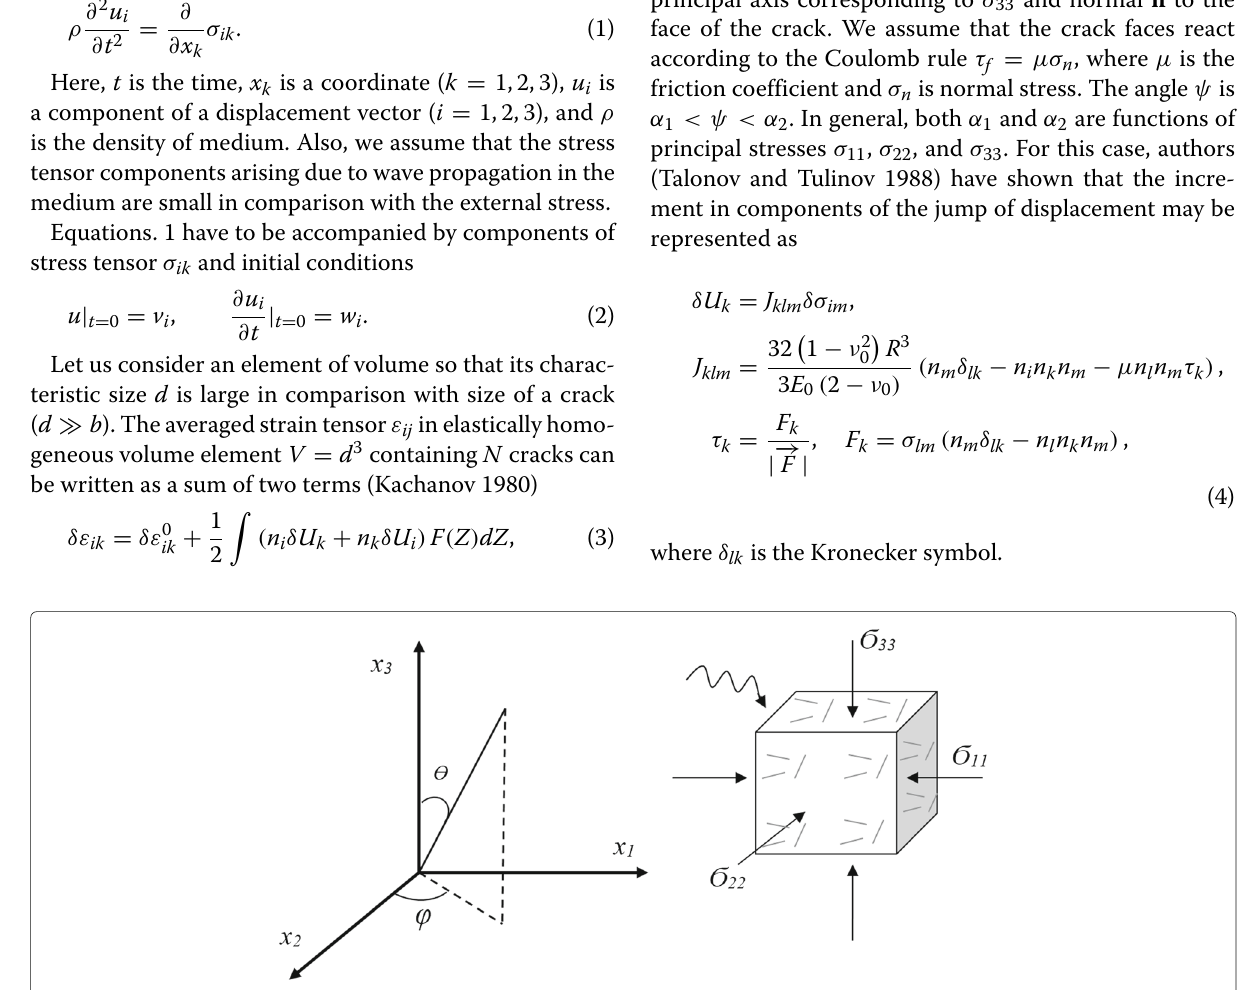
Fig. 1 Coordinate system. Elastic wave propagates through pre-loaded fractured